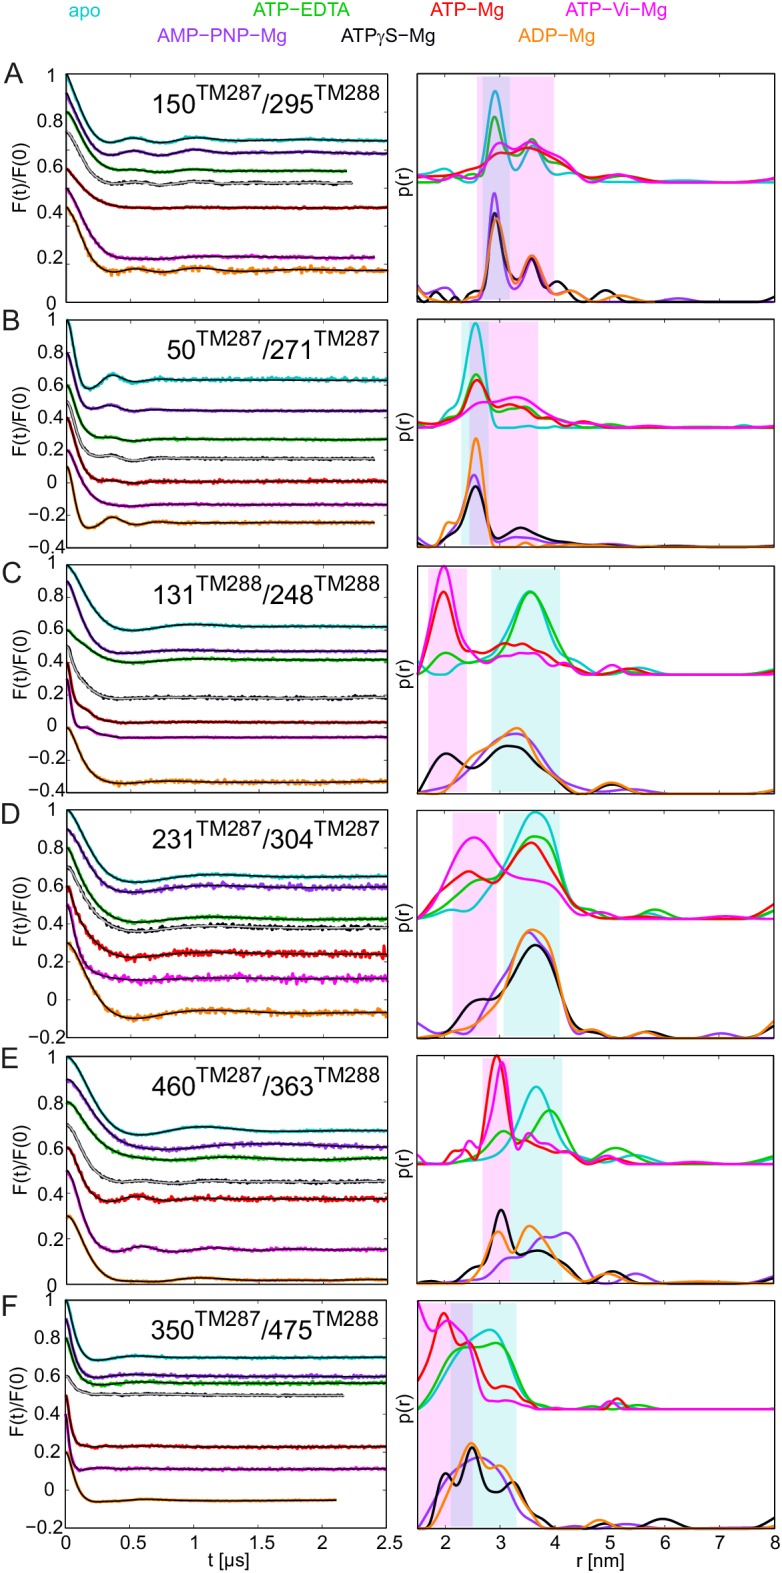
DEER analysis of spin-labeled pairs in wildtype TM287/288 with additional nucleotide analogs and ADP-Mg.Q-band background-corrected DEER traces [F(t)/F(0)] with fitted distribution function (left) and corresponding distance distribution (right) for the six spin-labeled pairs engineered into wildtype TM287/288. The upper distance distributions correspond to those presented in Figure 2, the bottom distributions to the additional nucleotide analogs and ADP-Mg. (A and B) Extracellular pairs 150TM287/295TM288 and 50TM287/271TM287. (C and D) Intracellular pairs 131TM288/248TM288 and 231TM287/304TM287. (E) NBD pair 460TM287/363TM288 monitoring the consensus site. (F) NBD pair 350TM287/475TM288 monitoring the degenerate site. The data of the apo and AMP-PNP-Mg states of the four pairs 150TM287/295TM288, 131TM288/248TM288, 460TM287/363TM288, 350TM287/475TM288 in the wildtype transporter are taken from (Hohl et al., 2014).